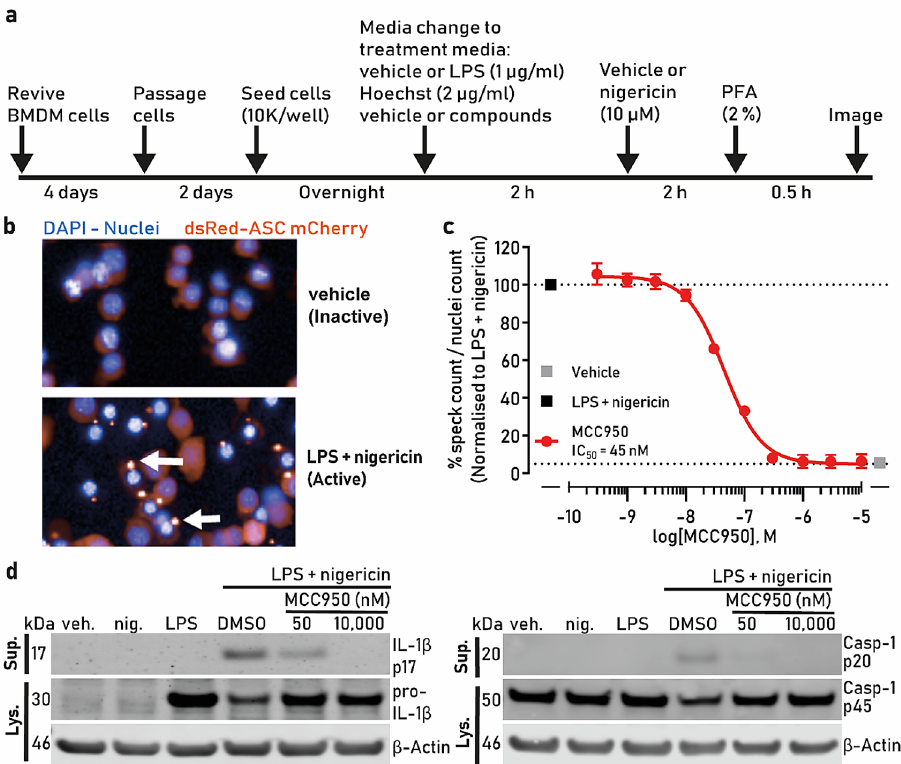
Figure 1. High-content imaging assay development. ( a ) Schematic of the assay protocol. ( b ) Untreated iBMDM cells show weak mCherry fluorescence, which strongly increases and localizes into a speck after inflammasome activation with LPS and nigericin (white arrows). Cell nuclei are visible in blue and ASC-mCherry in red. ( c ) ASC-mCherry iBMDM cells were treated with the indicated concentrations of MCC950 and LPS (1 µg/ml) for 2 h followed by nigericin treatment (10 µM, 2 h) after which PFA was added. The percentage of ASC specks/ total nuclei normalised to LPS and nigericin is presented; ( d ) Immunoblot of pro-IL-1β and cleaved IL-1β (IL-1β p17), pro-caspase-1 (p45) and caspase-1 (p20) in the cell lysates and supernatants after cell stimulation with LPS + nigericin in the presence or absence of MCC950 (50 or 10,000 nM). β-actin was used as a loading control for the cell lysate samples. The IL-1β and caspase-1 bands are cropped from their respective blot images and the full-length blots are presented in Figure S5. Data in ( c ) are presented as mean ± SEM, n = 3 independent experiments and was analyzed using GraphPad Prism version 7 software (https:// www. graph pad. com/ scien tific- softw are/